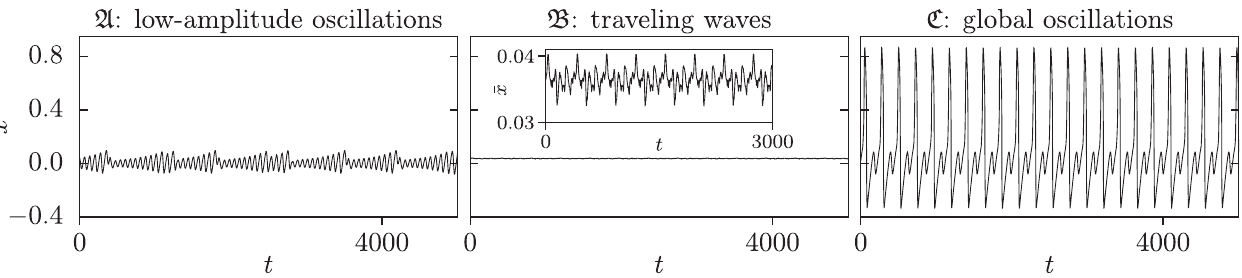
FIG. 2. Exemplary temporal evolutions of ¯ x for the attractors A , B , and C . The inset in the middle panel shows a zoom with enlarged amplitudes.